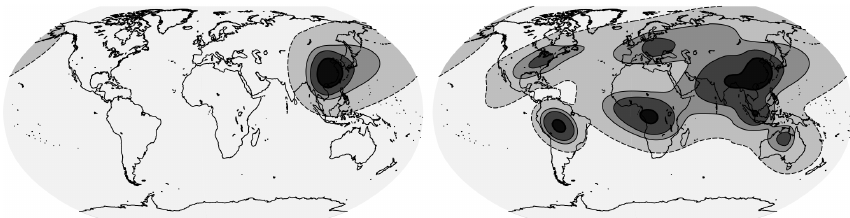
Figure 2. Horizontal spatial pattern of the anthropogenic aerosol optical depth plumes. Single east Asian plume is on the left; all nine plumes, right. Contour levels are 0.005 (dashed), 0.05, 0.1 and 0.3 (thickened). Plumes are shown for September 2005, a time of year when there is also a substantial anthropogenic contribution from tropical and Southern Hemisphere biomass burning.